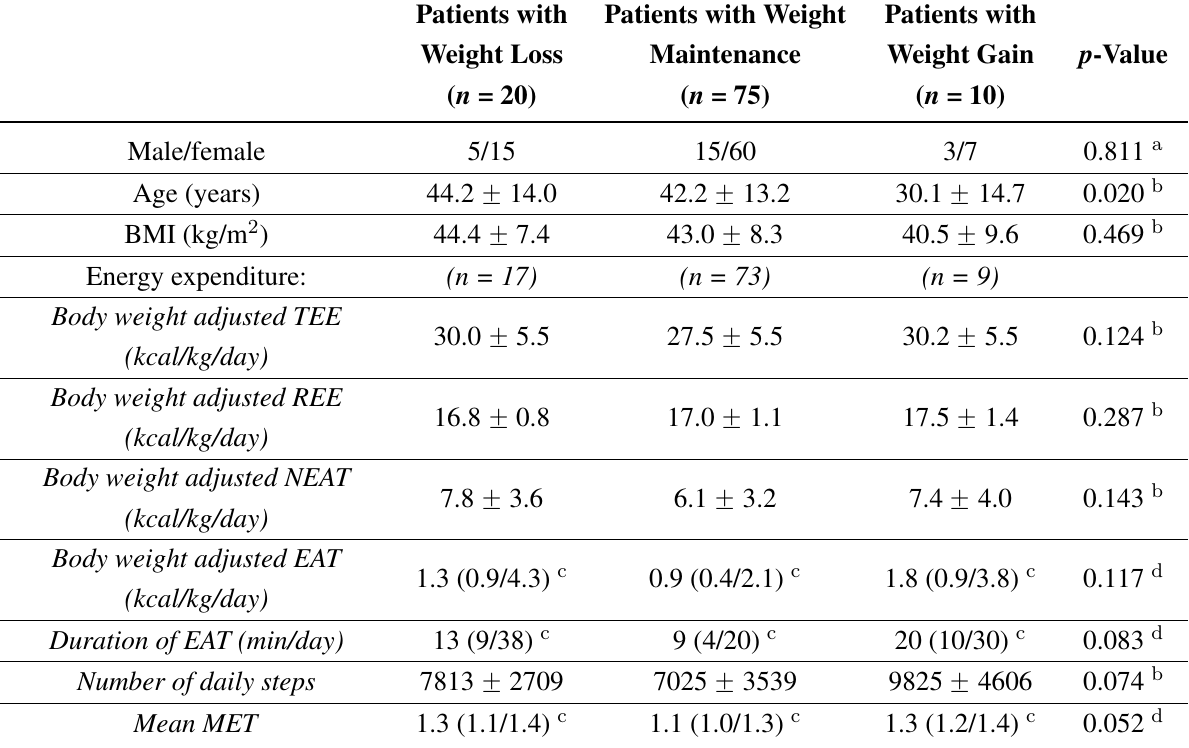
Table 3. Subject data, energy expenditure and pattern of physical activity at baseline according to weight